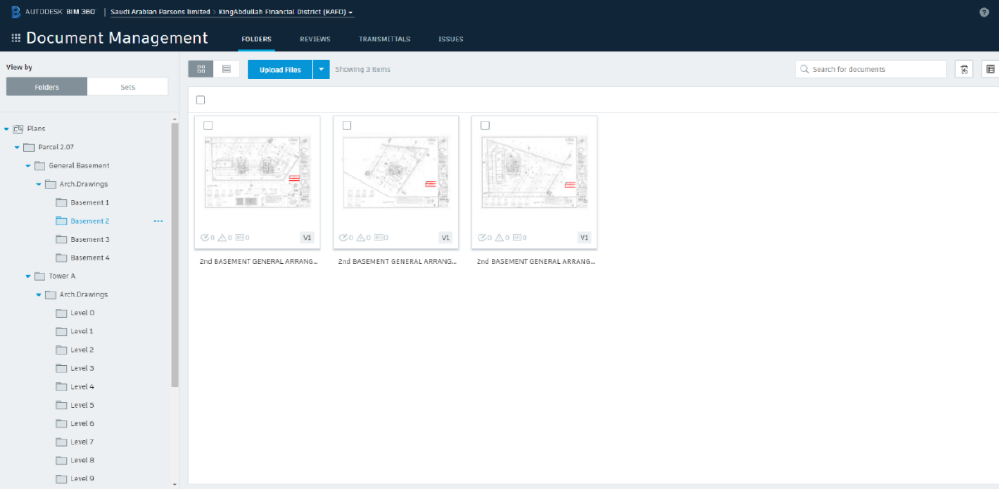
Figure 11: The Drawings in BIM 360 Docs